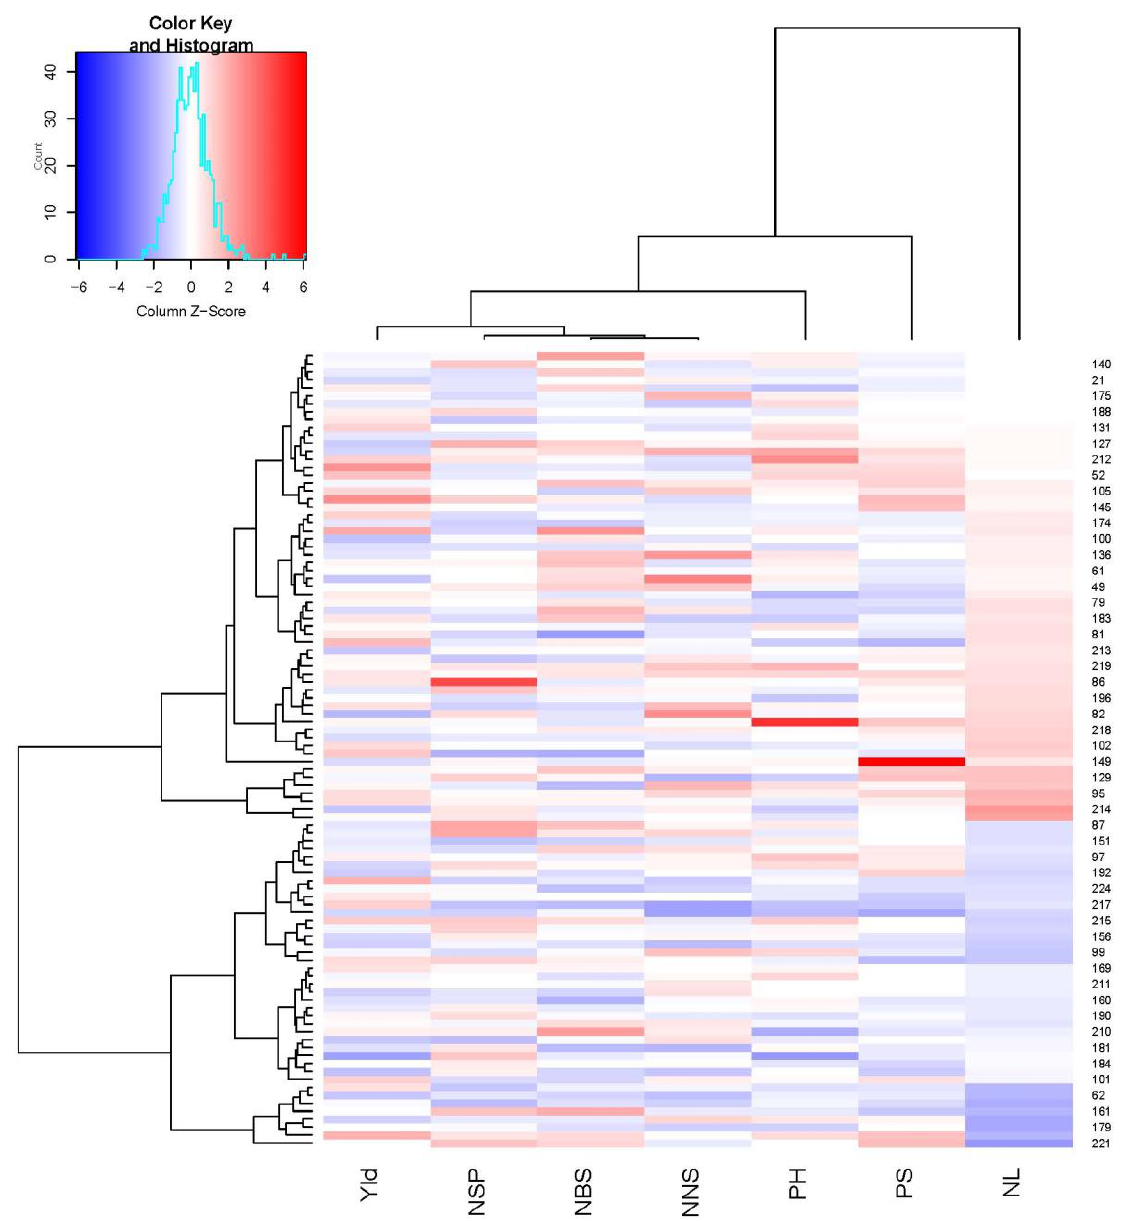
Figure 3. Heat map of grain yield and yield components measured in 100 accessions in Vaalharts in 2016 – 2017 and 2017 – 2018 growing seasons and at Roodeplaat 2016 – 2017 season. PH, plant height; PS, plant spread; NNS, number of nodes per stem; NL, number of leaves per plant; NSP, number of stems per plant; NBS, number of branches per stem; YLD, grain yield.